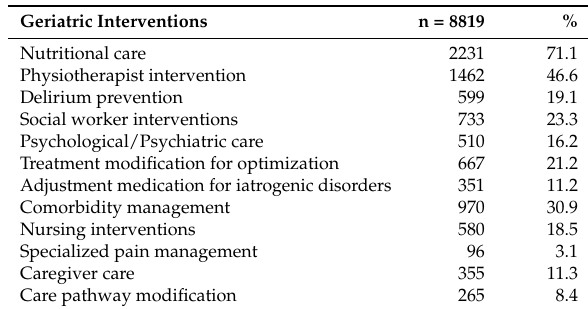
Table 3. Geriatric guided interventions.